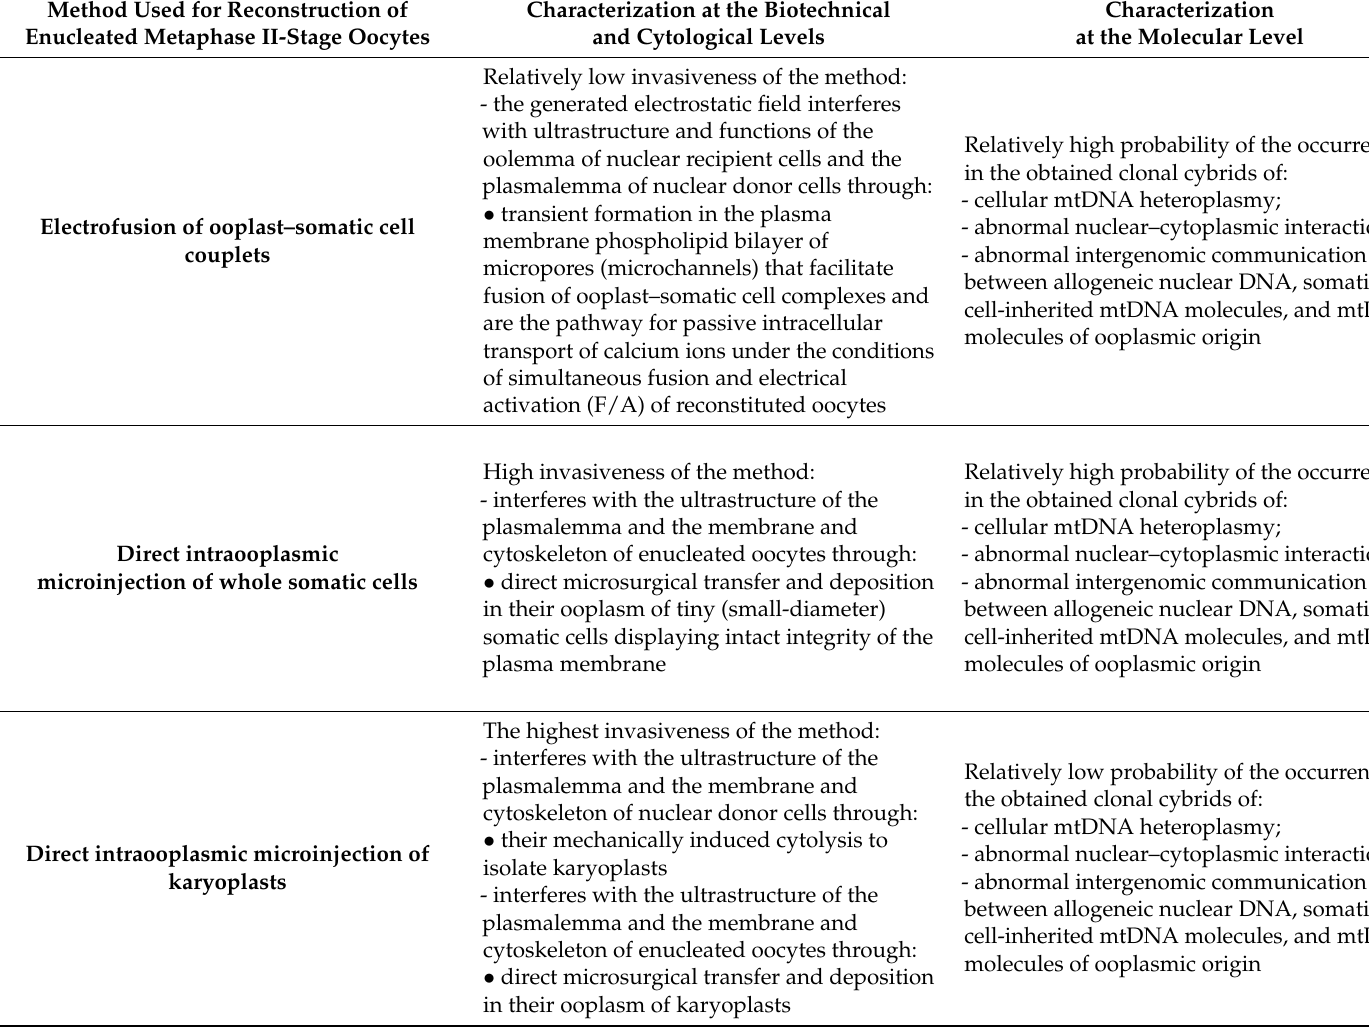
Table 1. Comparative characterization of the approaches to reconstruction of enucleated mammalian oocytes at the biotechnical, cytological, molecular, and epigenetic levels. Method Used for Reconstruction of Enucleated Metaphase II-Stage